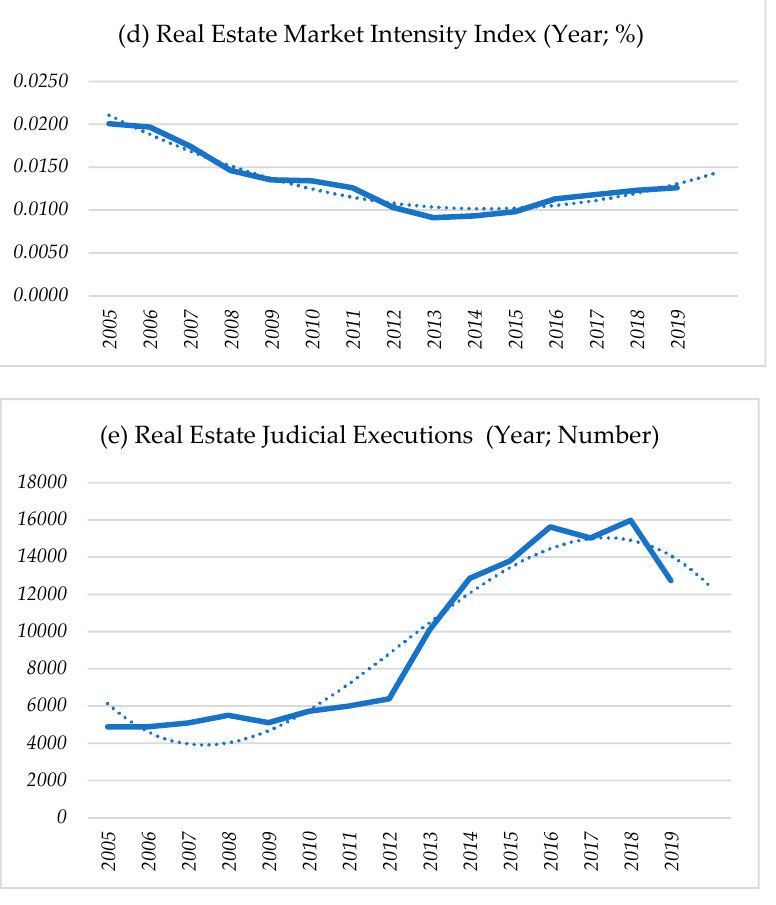
Figure 1. Graphical trend of the macroeconomic regressors (our elaboration on data provided by Italian National Institute of Statistics, Italian Agency of Revenue, Bank of Italy, Astasy, and other private sources): ( a ) Average Household Income (AHI); ( b ) Number of Unemployed (UNEMP); ( c ) Per Capita Income (PI); ( d ) Real Estate Market Intensity Index (IMI); ( e ) Number of Real Estate Judicial Executions (JEX). The reference year is always indicated on the x axis. Bold line contains the observed values of variables, dash line represents the trend line.